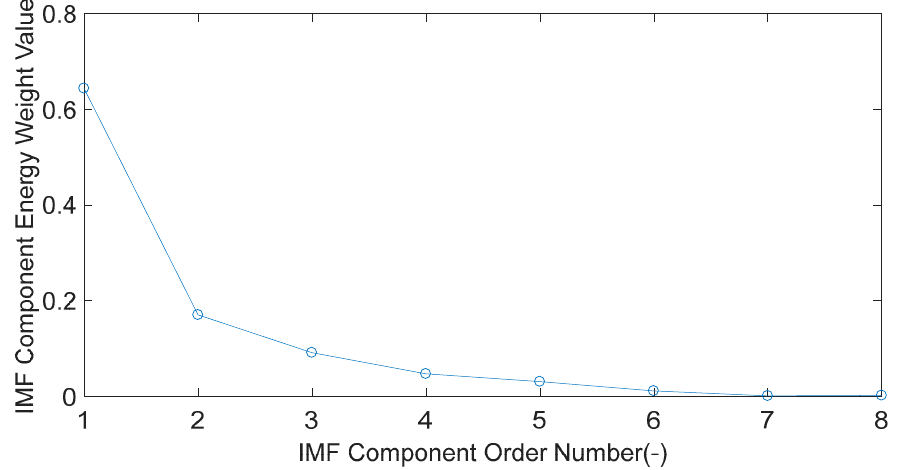
Figure 5. The energy weight value of eight Intrinsic modal Function (IMF) components.